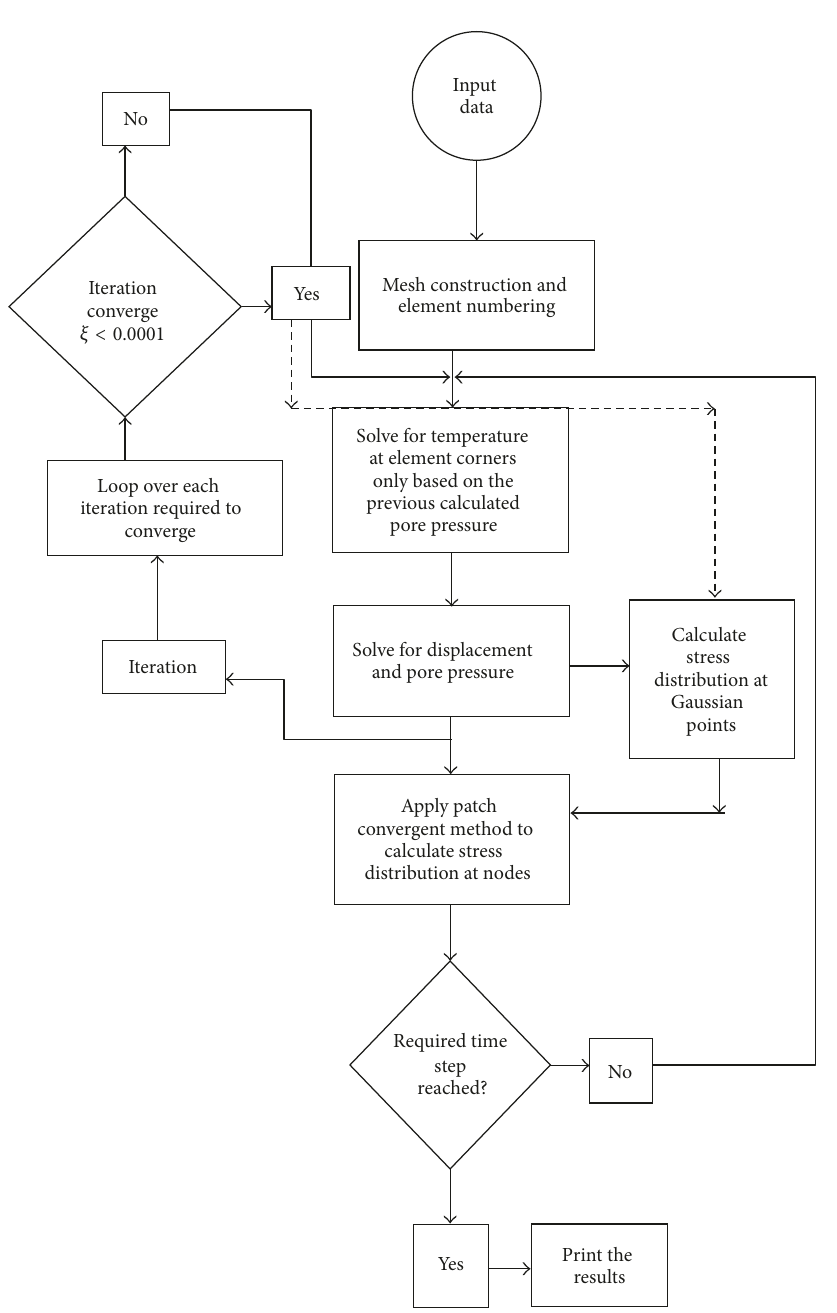
Figure 2: Flow chart describes how the nodal unknowns are solved using iterations